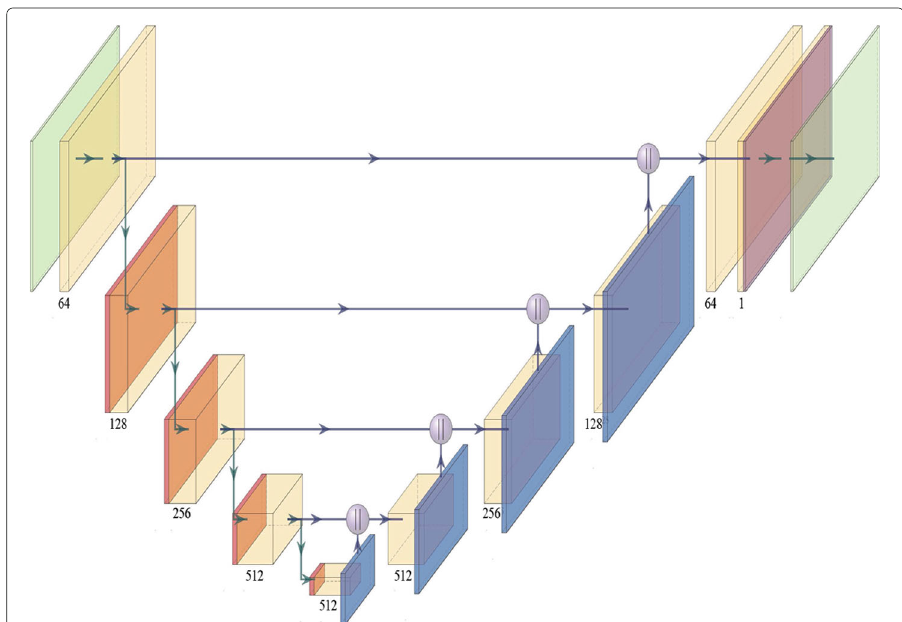
Fig. 2 A U-shaped deep convolutional neural network for appliance detection. The input energy consumption matrix is represented by a green layer on the upper left corner and the data flow inside the model is indicated by arrows. Then, the input data would be processed by successive convolution blocks (yellow blocks) for feature extraction. Red layers transit and downscale the output of the previous convolution block with a convolutional layer and a MaxPooling layer reducing data amount; deconvolutional layers (blue layers) reconstruct the feature map using the previous convolution block output. Also, the model concatenates the down-sampled feature maps and up-sampled feature maps upgrading the reconstruction performance, indicated by ball symbols in the graph. After that, the processed feature map would be reformed with the same size as the input matrix, and every data point would be predicted by the sigmoid classifier (magenta layer). Finally, the output matrix at the upper right corner of the plot would present the binary prediction of each data point by using “0” (state “off”) and “1” (state “on”)